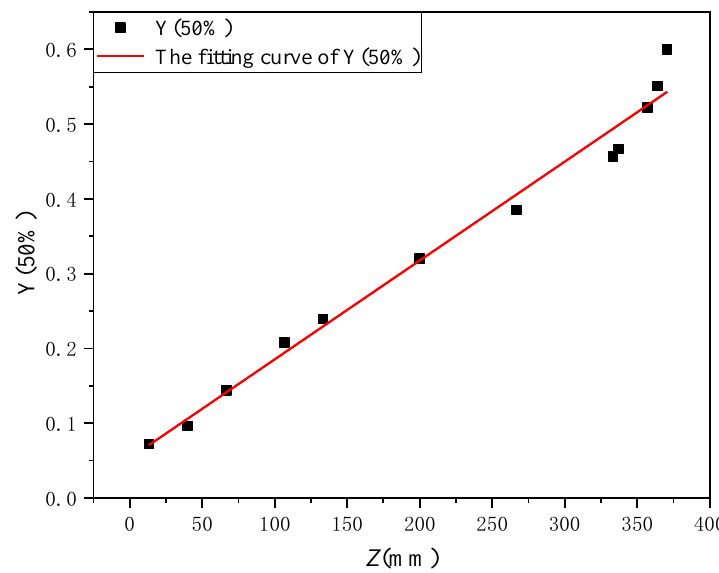
Figure 6. The relationship between the half-value width of the speed and the